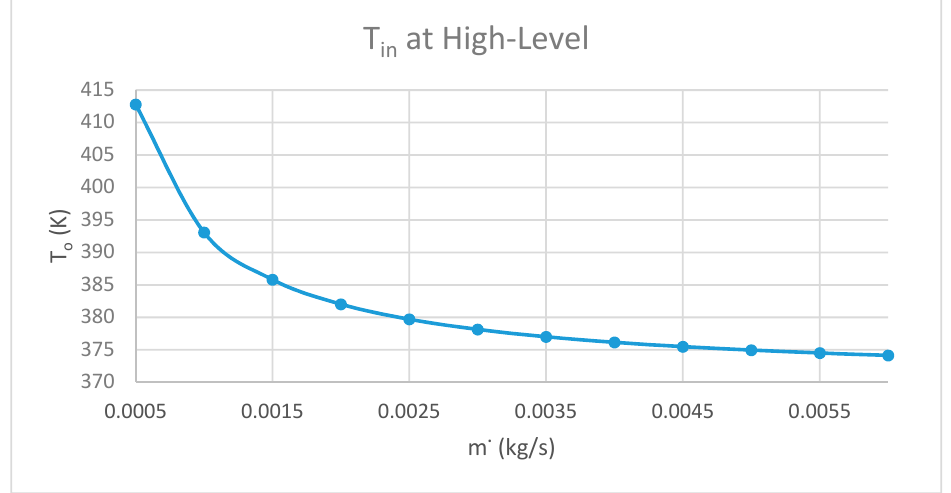
Figure 6. The effect of inlet flowrate on the outlet water temperature at high-level inlet temperature.